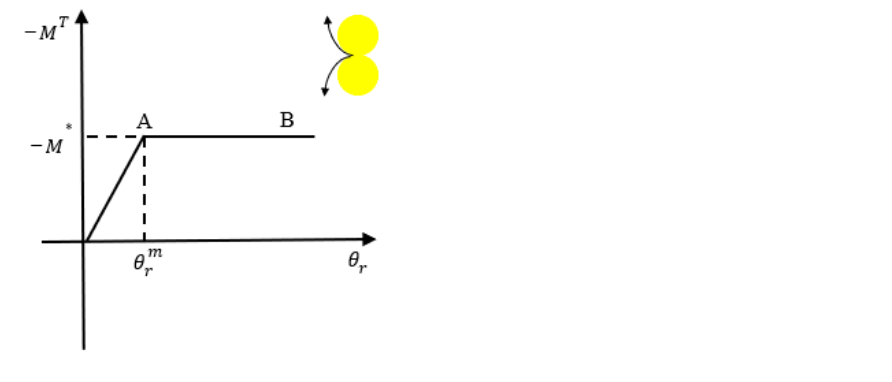
Figure 3. Anti-rolling torque contact model. (Adapted with permission from Ref. [36]. 2020, Wang, H; Zhou, Z.Y.; Zhou, B).